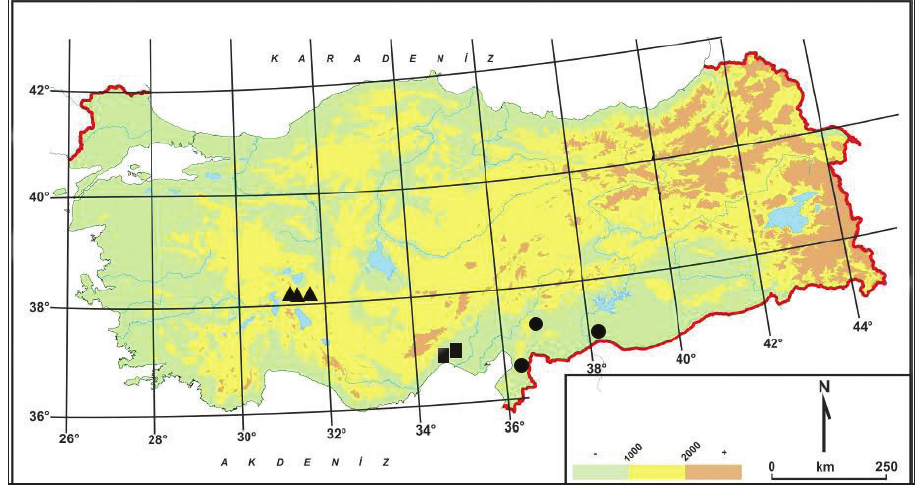
Figure 1. Distribution map of Linum aksehirense ( triangle ), and closely related Linum pubescens ( circle ) and Linum anisocalyx ( square ) in